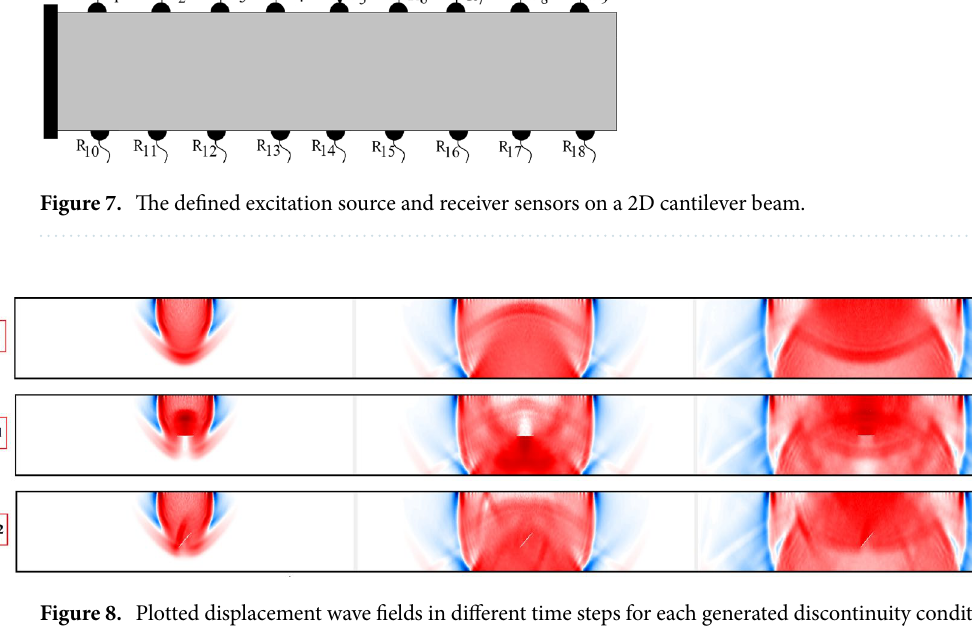
Figure 8. Plotted displacement wave fields in different time steps for each generated discontinuity condition: NC, SC1, and